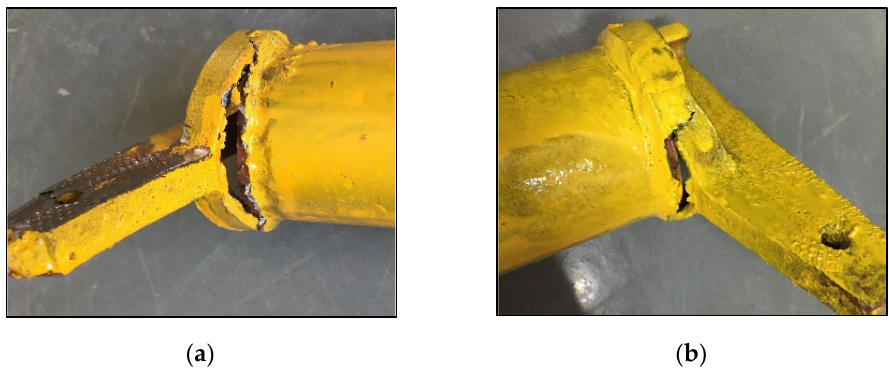
Figure 3. Failure mode of sockets on horizontal bars: ( a ) SJ-1; ( b ) SJ-2.